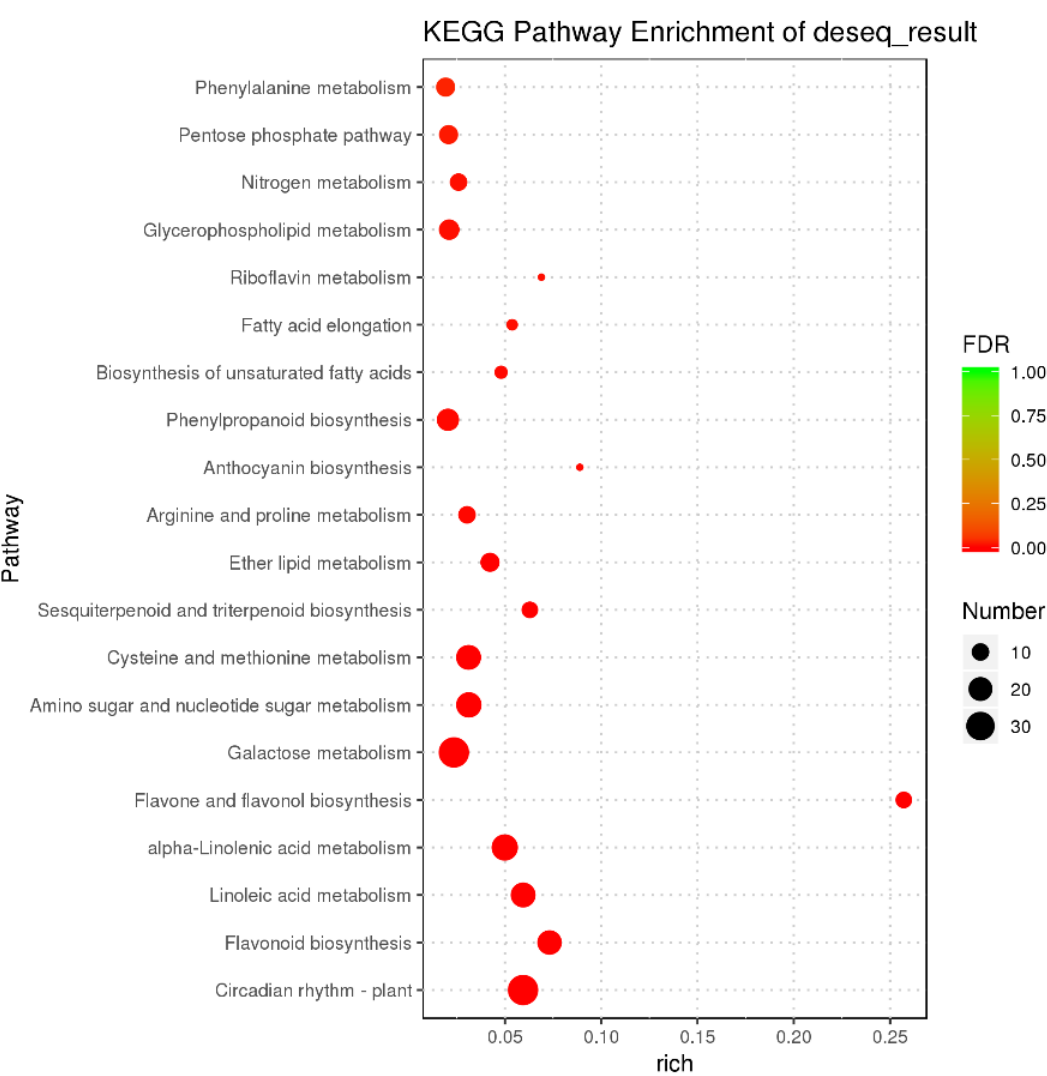
Figure 7. DEG analysis by the KEGG pathway of C. oleifera leaves under RL vs. BL.